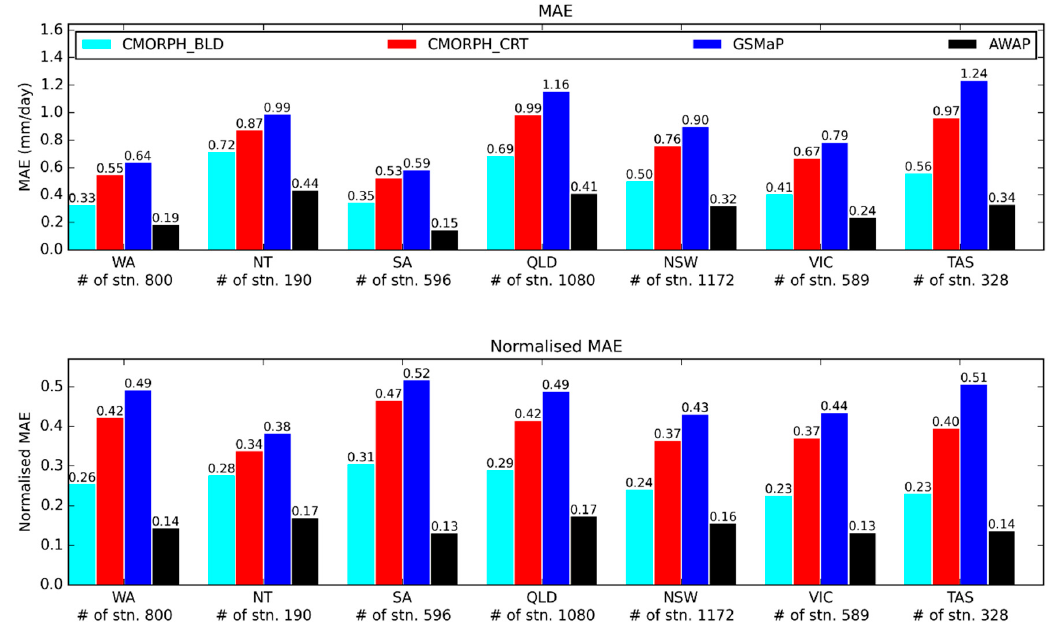
Figure 7. Point-based comparison categorised by states from January 2001 to December 2018 using station gauges as truth.